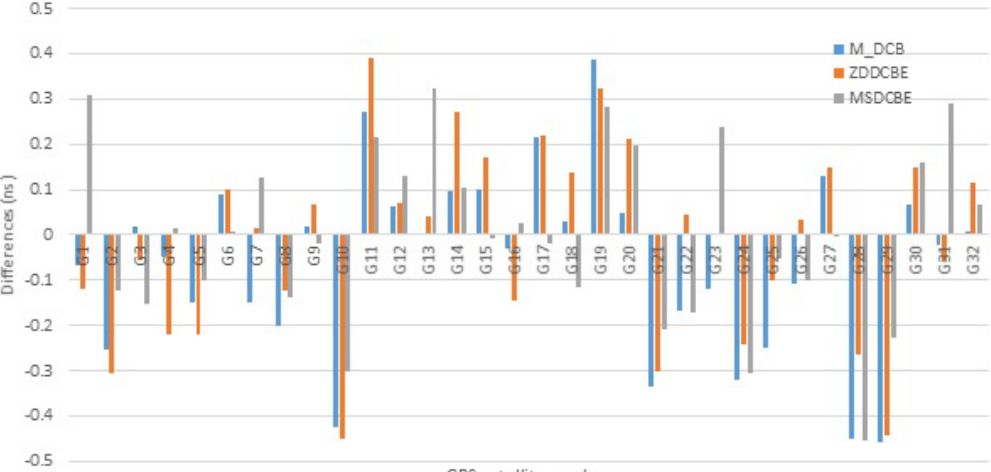
Figure 8. Mean difference between the satellite DCB values of the IGS and the computed values by M_DCB, ZDDCBE, and MSDCBE estimated from 1 to 5 January